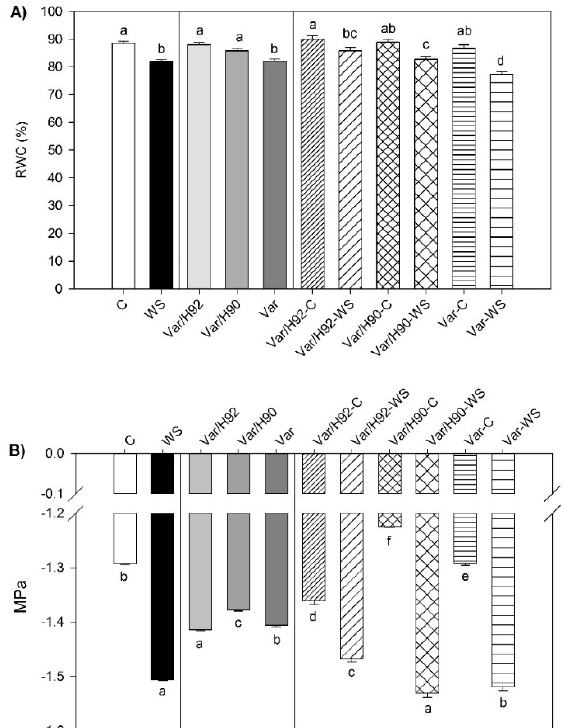
Figure 1. ( A ) Relative water content (RWC) and ( B ) osmotic potential ( Ψ s) in leaves for the ungrafted plants (Var, variety “Sueca”) and Var grafted onto H92 or H90 (Var/H92 and Var/H90, respectively) under the water stress (WS) or control conditions (C). Measurements were taken at 30 DAT (days after treatment). Data are the mean of four replicates and the error bars belong to the standard deviation for each plant type and treatment combination. Different letters indicate significant differences at p < 0.05 (least significance difference (LSD) test).